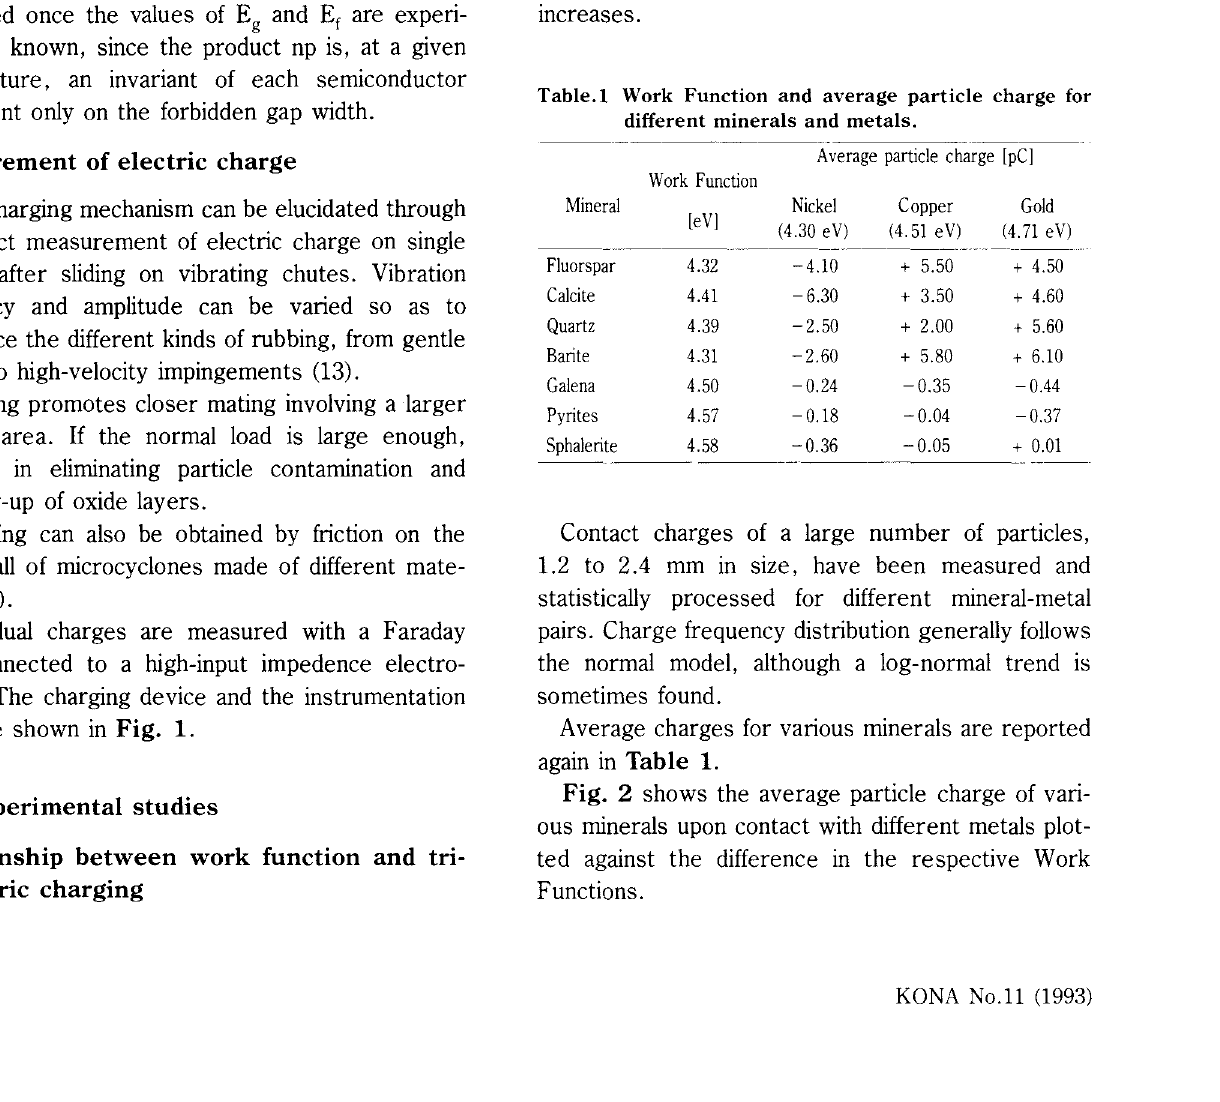
Fig. 1 Experimental set -up for the measurement of tribocharge on individual particles.